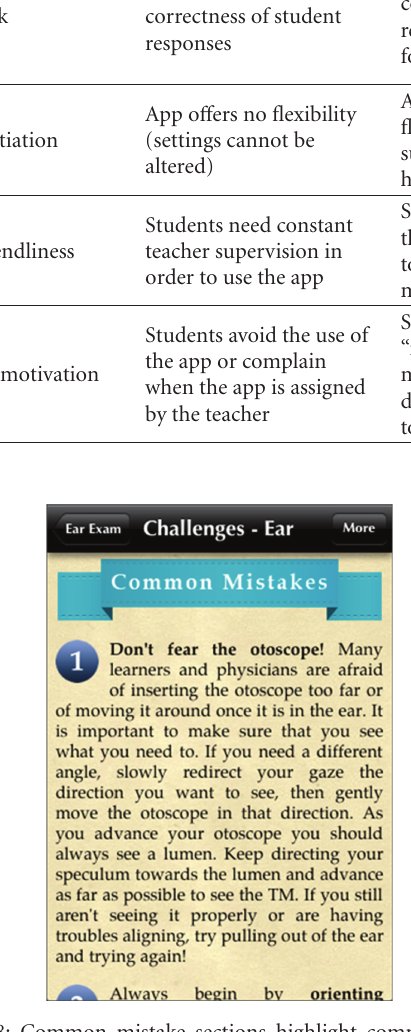
Figure 8: Common mistake sections highlight common learner challenges for each facet of the OTOHNS physical